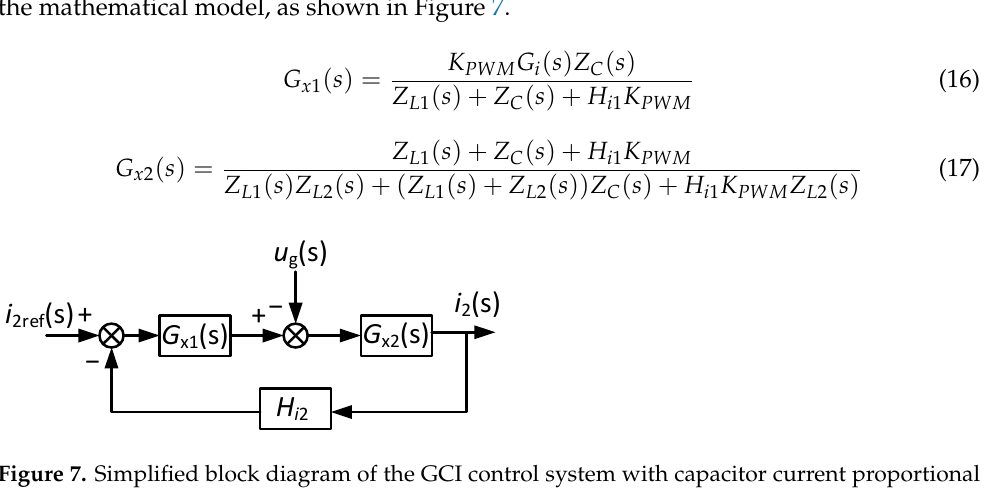
Figure 7. Simplified block diagram of the GCI control system with capacitor current proportional feedback.